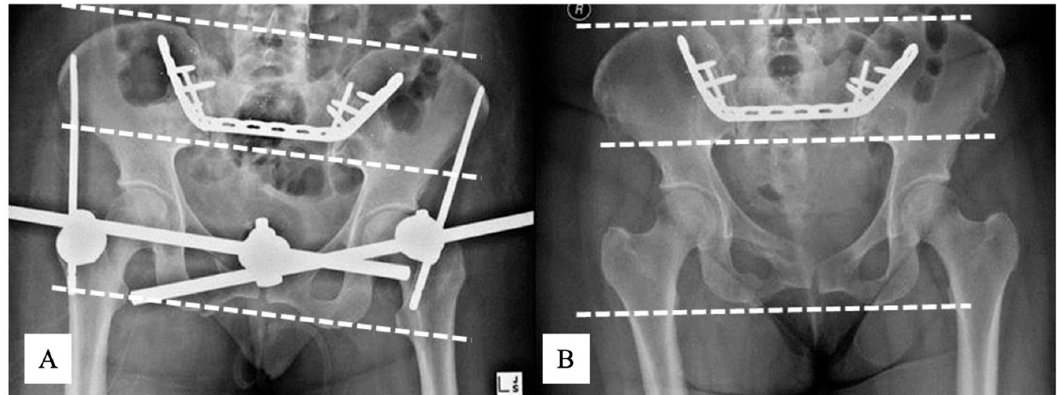
Figure 3. AP X-rays of Patient 2 pelvis immediately after reduction and fixation ( A ) and at 104 weeks follow-up ( B ). In this patient, RSA measured a 1 cm fracture translation during healing. Note that there are no measurable vertical translations on plain radiographs, and that the iliac bones project relatively symmetric on each image. Note the slightly di ff erent projections of the pelvis between examinations. The dotted lines correspond to a horizontal plain. AP, antero-posterior; RSA, radiostereometric